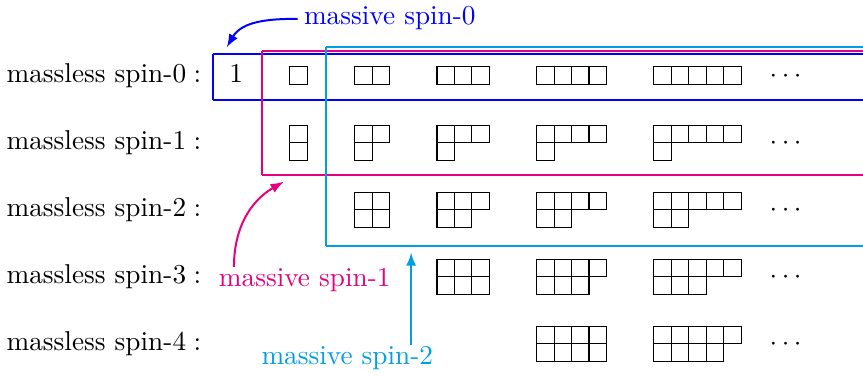
Figure 1 . The mode decomposition of massive single particle modules reflects the Higgs mechanism: a massive particle can be thought of as the combination of transverse polarizations — interpolated by a massless particle of the same spin — together with longitudinal polarizations that are interpolated by a series of massless particles of lower spin, e.g. eqs. (3.24) and (3.22) for a massive vector, and eq. (A.16) for general massive spin- k particles. For the treatment of massive particles of general spin see appendix